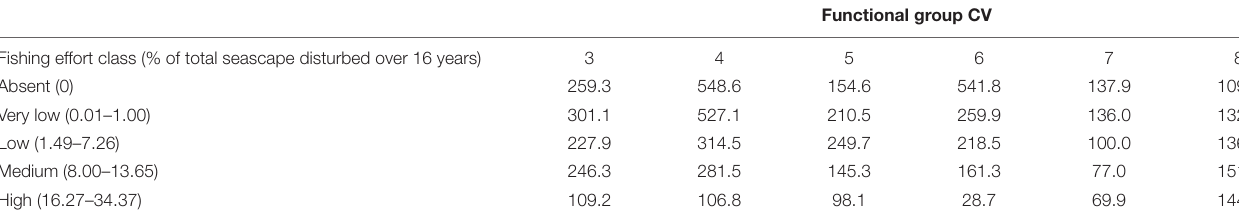
TABLE 4 | Coefficient of variation (CV) between fishing effort classes and functional group abundance.